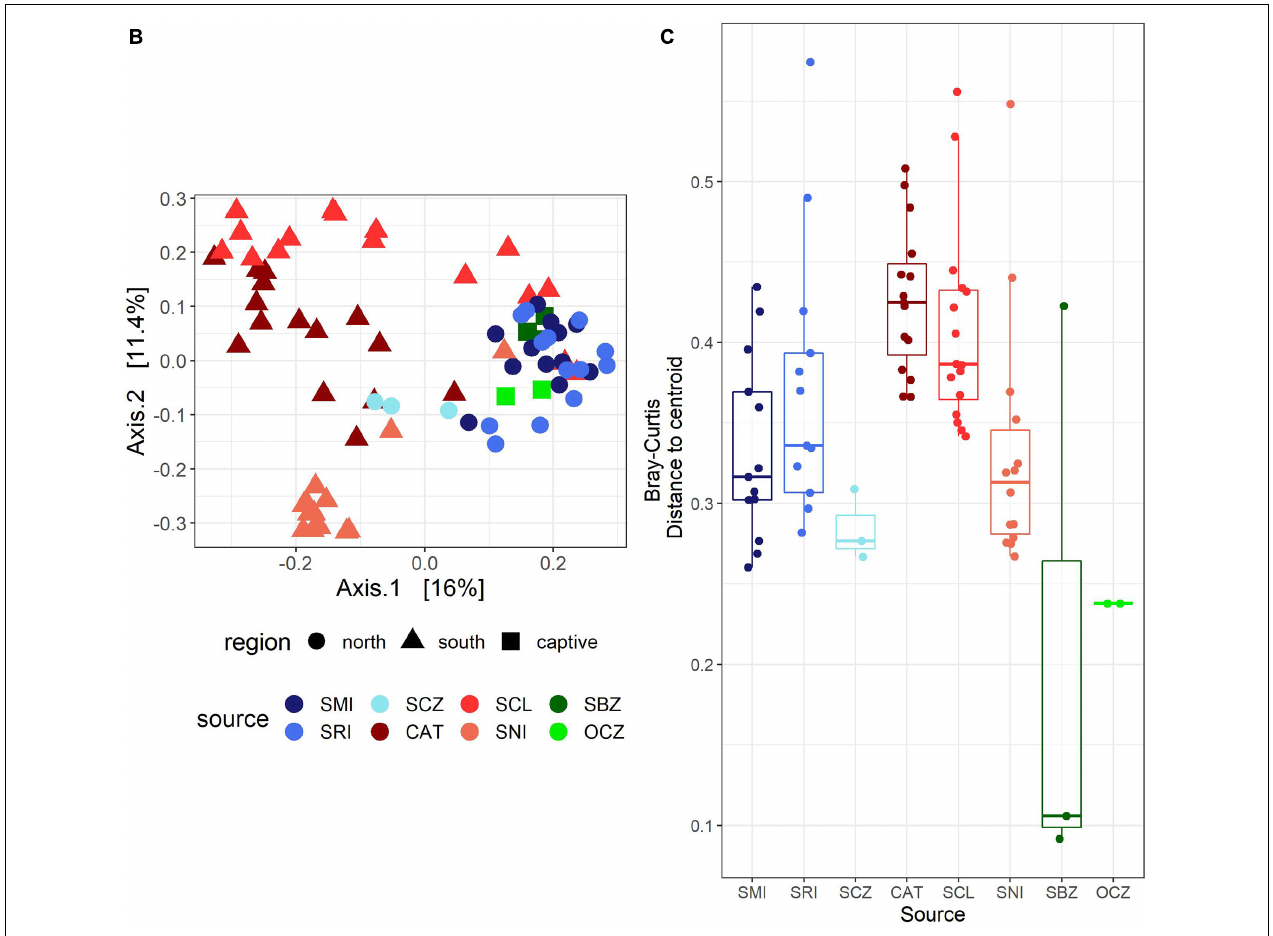
FIGURE 3 | (A) Dendrogram of transformed data based on Bray–Curtis dissimilarity. Sample names are colored by island or zoo (see Figure 1 ) and shapes correspond to region: circle = northern islands, triangle = southern islands, and square = captive samples. (B) Principal coordinates analysis (PCoA) based on Bray–Curtis dissimilarity. The points are samples colored by source (island or zoo) and the shapes represent northern or southern Channel Islands and captive samples. (C) Boxplot of multivariate dispersion as measured by the distance to the centroid per sample and displayed by